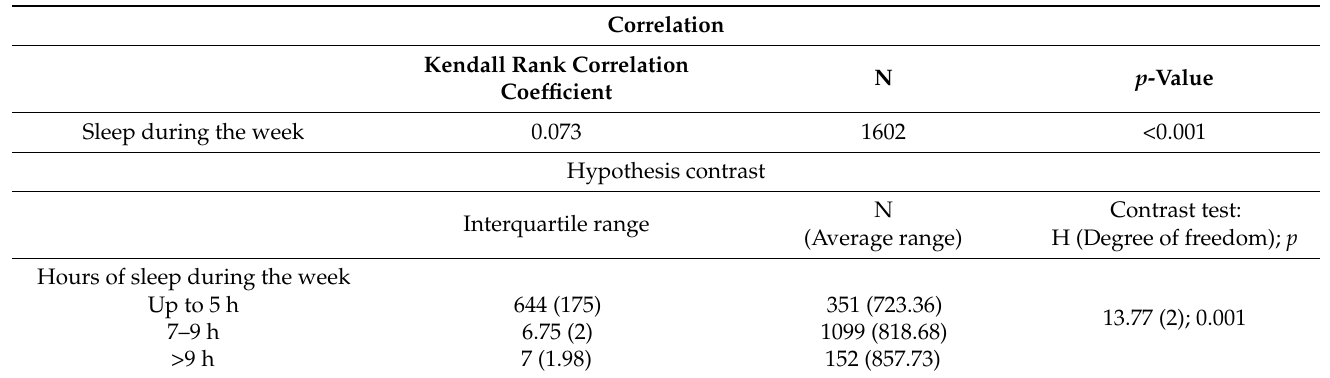
Table 2. Relationship between sleep patterns and academic performance.